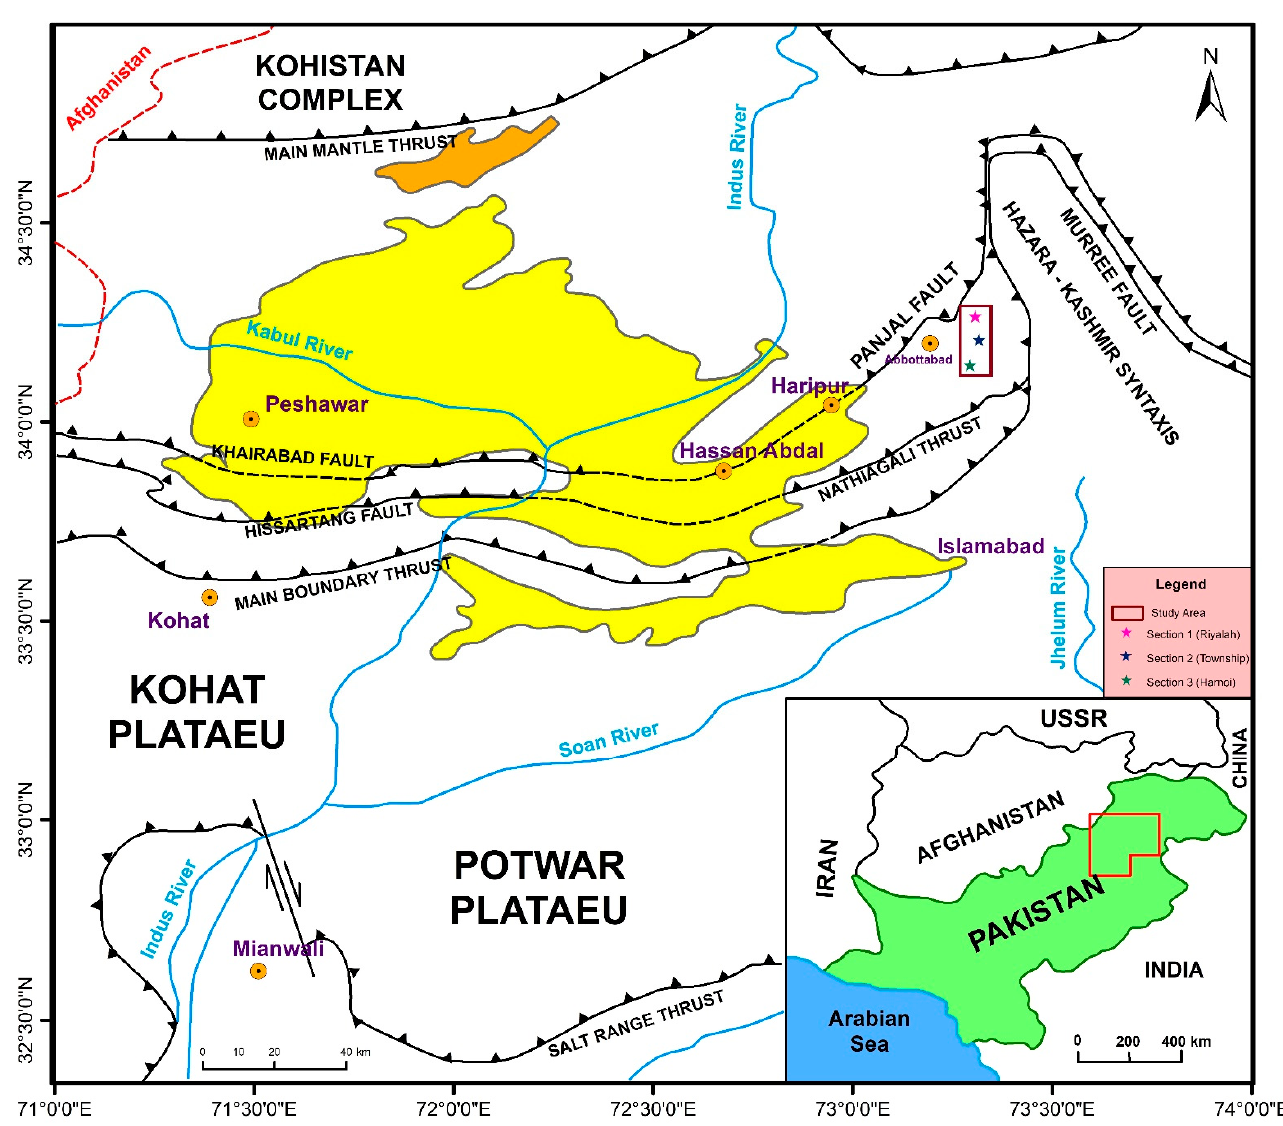
Figure 1. Tectonic map showing a segment of the Northwestern Himalayas’ fold and thrust belt. The rectangle indicates the location of the research area.